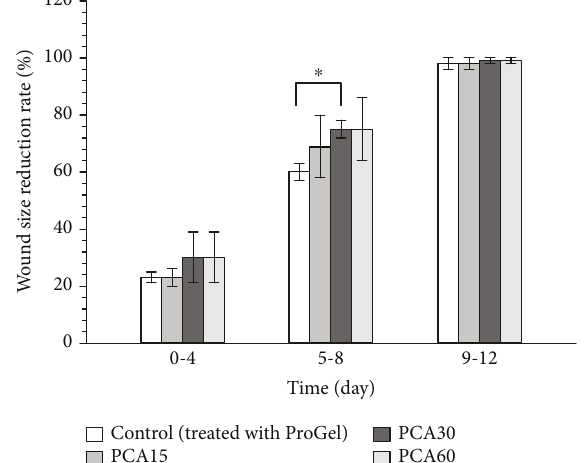
Figure 6: The rate of wound size reduction measured after 4 days, 8 days, and 12 days ( n = 3 ). The asterisk on the bar graph indicates signi fi cant di ff erence ( p < 0 05